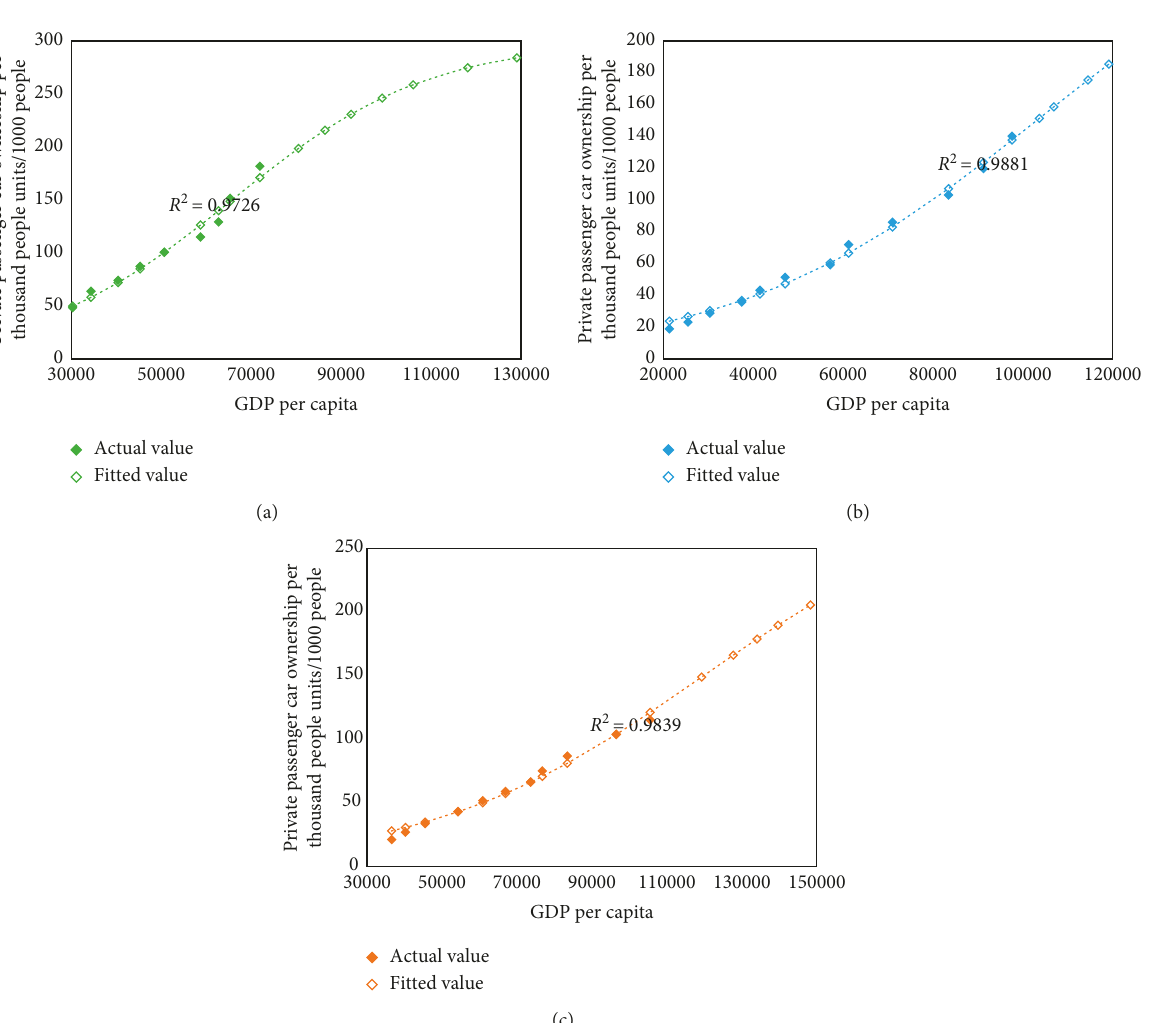
Figure 9: Actual and fitted values of private passenger vehicle ownership based on GDP per capita in (a) Beijing, (b) Tianjin, and (c)